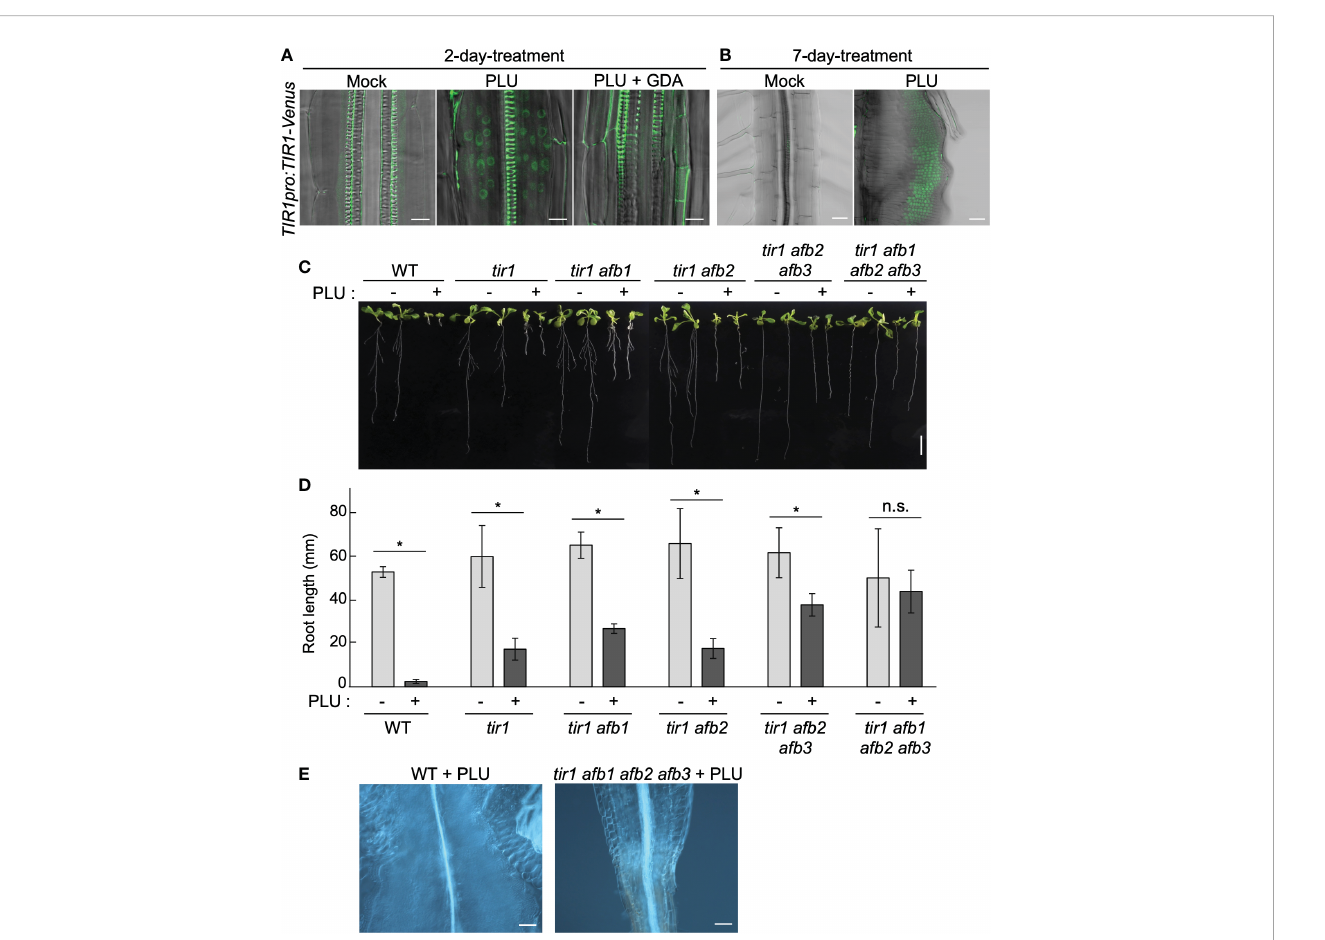
FIGURE 6 HSP90-dependent induction of auxin receptors is required for callus formation by PLU. (A, B) 5-dpi TIR1pro:TIR1-Venus seedlings were treated with or without 40 µM PLU and/or 20 µM GDA and observed after 2-day incubation (Scale bar: 50 µm) (A) or 7-day incubation (Scale bar: 10 µm) (B) . Fluorescent signals were merged with DIC images. Note that xylem strands show strong self- fl uorescence due to thick secondary cell wall. (C) Photos of 14-dpi wild-type or tir1/afb -family mutant seedlings grown on media containing DMSO (mock) or 40 µM PLU (Scale bar: 1 cm). Because some tir1/afb - family multiply mutant lines frequently fail to produce the primary root (Dharmasiri et al., 2005b), only seedlings that produced primary root were used for experiments. (D) The quanti fi cation graph of root length data in (C) . The mean ± standard deviation is shown. Sample size is n=8 except for tir1 afb1 afb2 afb3 (n=6). * indicates signi fi cant differences from mock treatment at P < 0.05, and n.s. indicates no signi fi cant difference based on Welch ’ s t test (two-tailed). (E) DIC images at the hypocotyl-root junction of 40 µM PLU-treated seedlings (Scale bar: 100